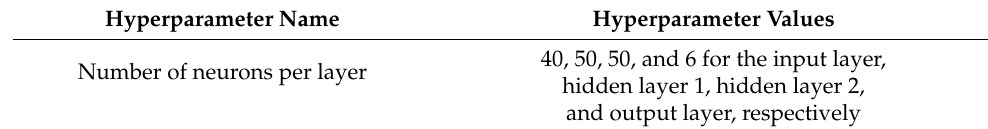
Table 2. Hyperparameters used for the tuning procedure during validation.